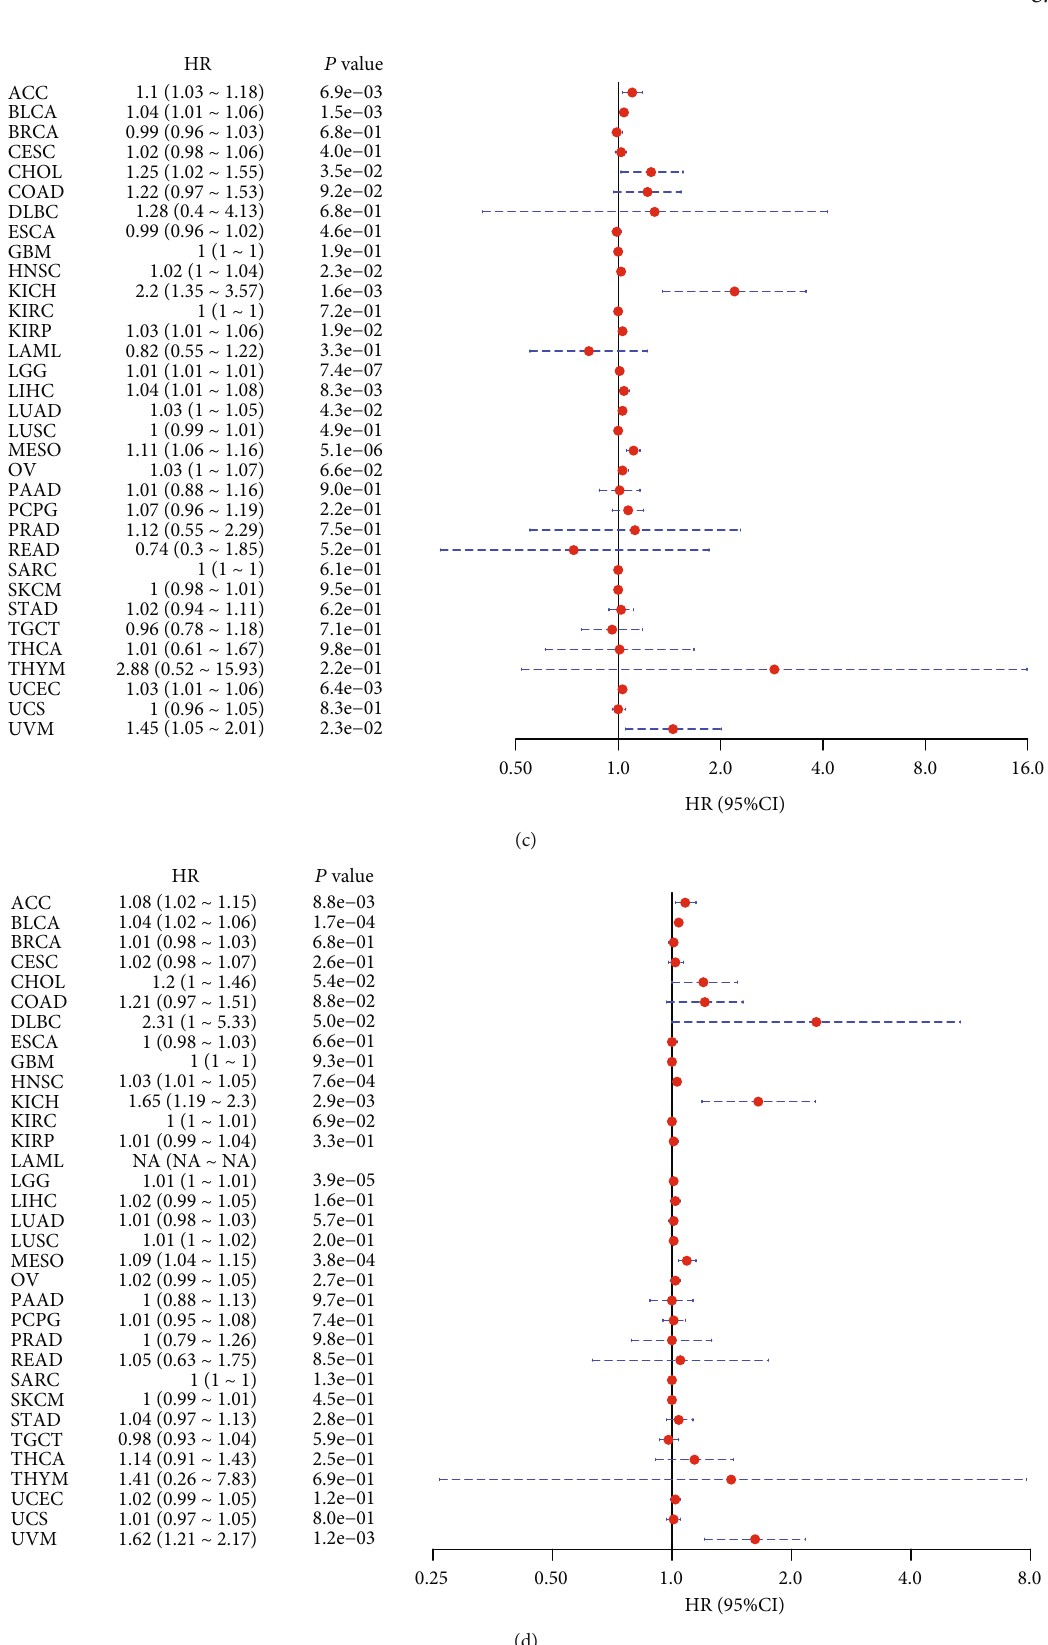
Figure 2: Univariate Cox analysis of (a) disease-free survival, (b) disease-speci fi c survival, (c) overall survival, and (d) progression-free survival in association with B4GALNT1 expression in multiple